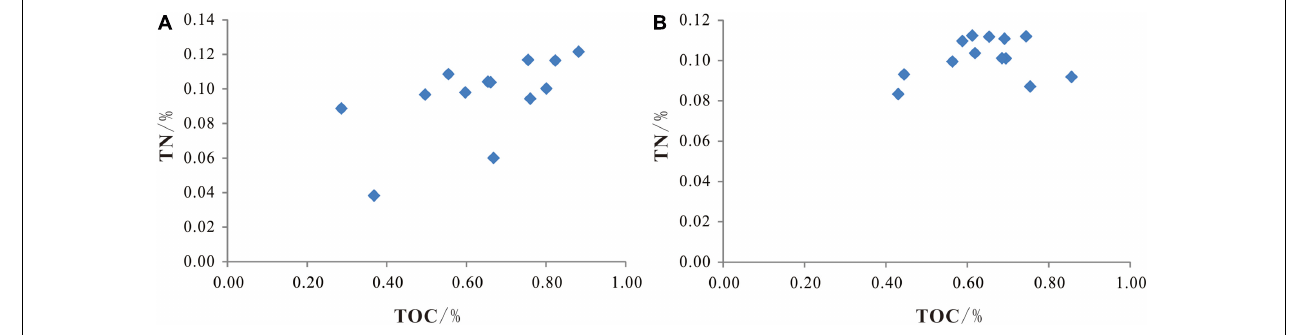
FIGURE 4 | The correlation of TOC and TN in core sediments (A,B) .